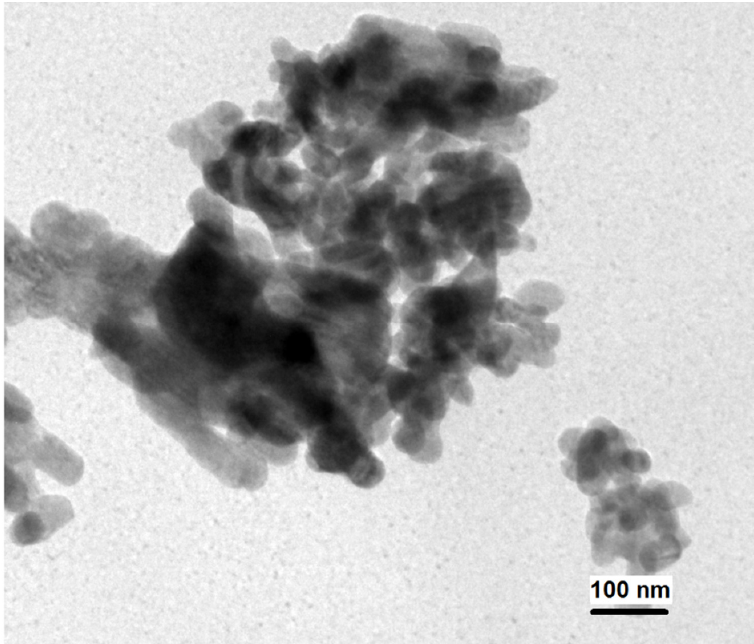
Figure 4. Transmission electron microscopy (TEM) image of the as ‐ prepared SrCO 3 ‐ Sr(OH) 2 nanoparticles without polypyrrole.